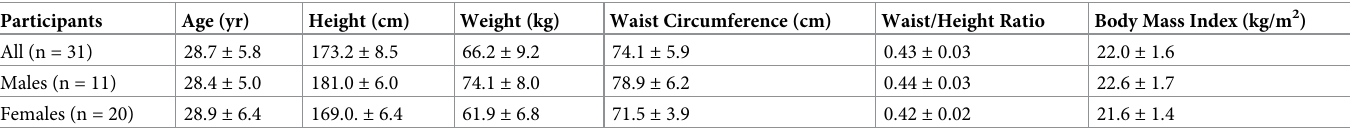
Table 1. Descriptive statistics of participants (mean ± standard